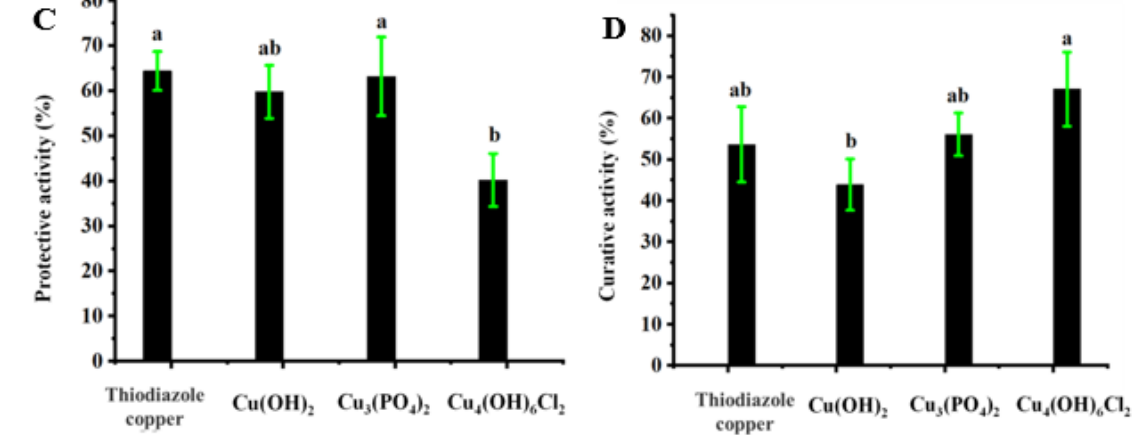
Figure 4. Control efficacies of copper-based nanomaterials and thiodiazole copper towards kiwifruit bacterial canker under controllable greenhouse conditions at 200 µ g/mL. Protective activities ( A , C ); therapeutic activity ( B , D ). A one-way ANOVA with an LSD multiple comparison test was used to determine significance across all the treatments. Values in each panel followed by different letters are significantly different at p < 0.05.